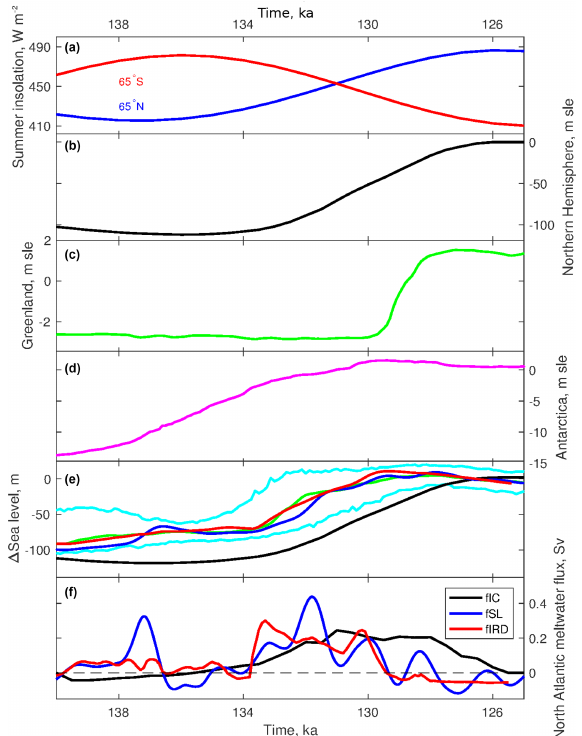
Figure 4. Time series of (a) summer solstice insolation at 65 ◦ N and 65 ◦ S, (b) – (d) global sea-level equivalent (m) of changes in (b) NH (Abe-Ouchi et al., 2013), (c) Greenland (Tarasov et al., 2012) and (d) Antarctic ice sheets (Briggs et al., 2014), (e) and global sea-level (m) change estimated from Red Sea records (Grant et al., 2014) (green) with the 95% probability interval (cyan), sea-level record with an adjusted age scale as described in Sect. 5 (blue) and as estimated from the continental ice-sheet simulations (black). The red line shows the changes in global sea level that would be obtained by adding the meltwater flux, fIRD, described in (f) plus an Antarc- tic contribution of 13m. (f) Possible North Atlantic meltwater flux (Sv) scenarios: estimated from the disintegration of NH ice sheets as shown in (b, c) (Tarasov et al., 2012; Abe-Ouchi et al., 2013) (black), estimated from the global sea-level change on the revised age scale (this study, blue) and scaled from the North Atlantic and Norwegian Sea IRD records (red, shown in Fig.